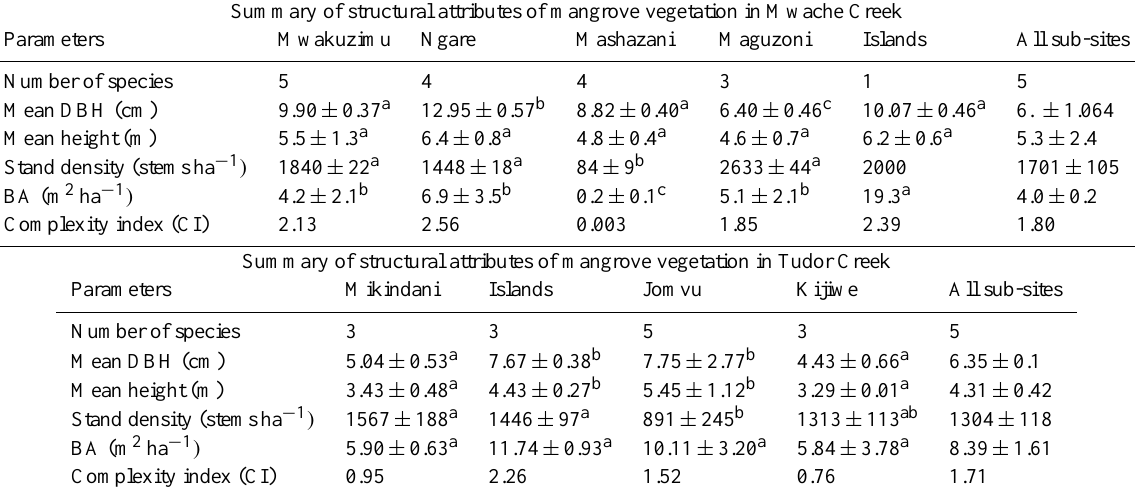
Table 1. Structural characteristics of Tudor and Mwache mangroves. Summary of structural attributes of mangrove vegetation in Mwache